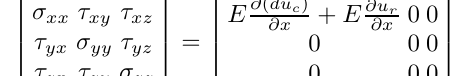
Fig. 5. Experimental shaker’s frequency response function (FRF) showing amplifications and attenuations that can be reach in the response even using the same intensity as input. stress field is simply given as